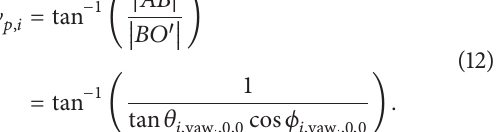
Figure 4: LOS 𝜃 1,0,0,0 and 𝜃 2,0,0,0 angle definitions for AP1 and AP2.